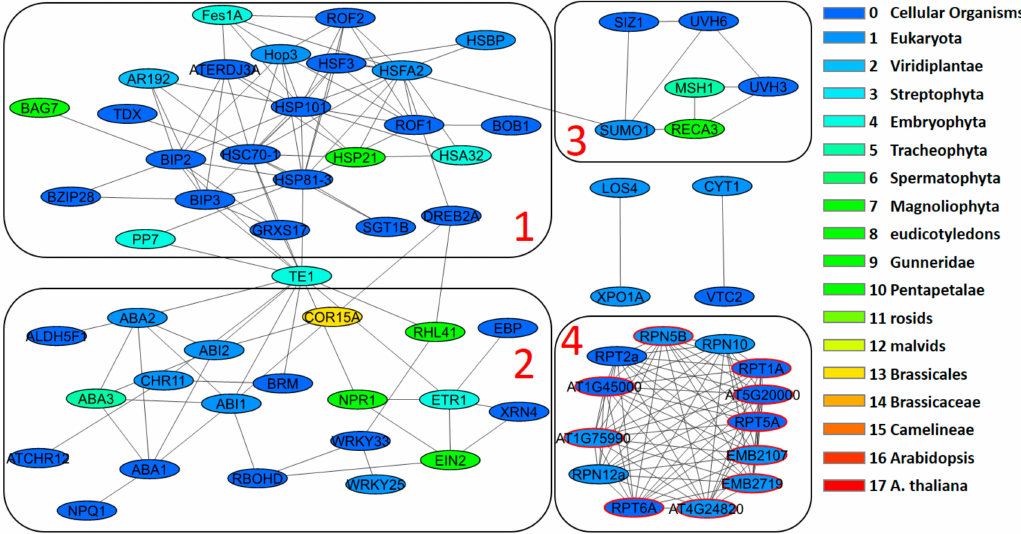
Figure 4. Gene network reconstructed for the heat associated gene set using the STRING tool. Node color corresponds to the PAI index of the gene from 0 (dark blue) to 17 (red). Nodes added to the gene set by the STRING procedure of network reconstruction are outlined in red color. The four clusters of genes are shown by rounded rectangles and